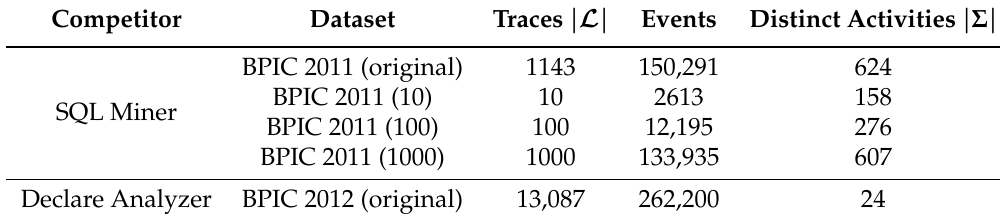
Table 7. Range of datasets used for benchmarking.